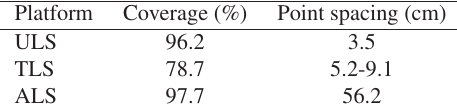
Figure 3. Subset of landslide surface a) photographed during fieldwork and visualised by point clouds acquired with b) ULS, c) TLS and d) ALS Table 1. Properties of different laser scanning